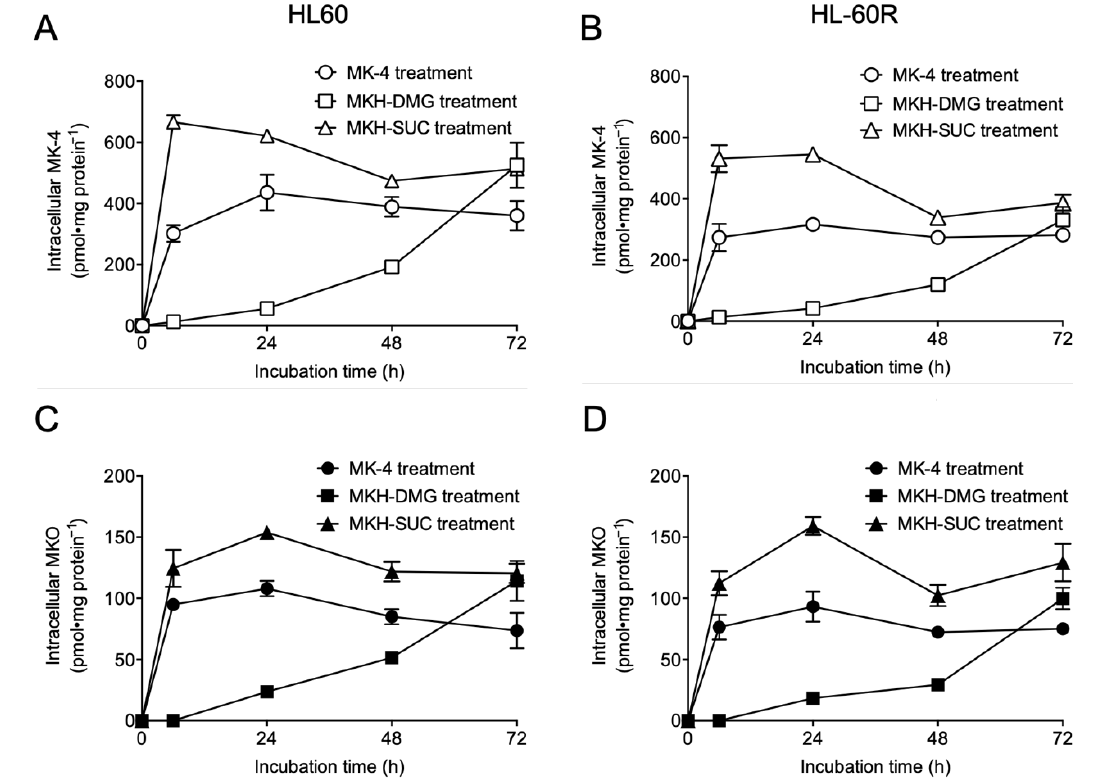
Figure 4. Intracellular concentration of MK-4 and MKO in HL60 and HL-60R cells treated with MK-4 or MKH derivatives. Intracellular MK-4 levels in HL60 ( A ) and HL-60R ( B ) cells treated with 5 μM MK-4, MKH-DMG, or MKH-SUC up to 72 h, and intracellular MKO levels in HL60 ( C ) and HL-60R ( D ) cells treated with 5 μM MK-4, MKH-DMG, or MKH-SUC up to 72 h. Plotted values are mean ± SD (n = 3). Table 2. Area under the curve over 72 h (AUC 0–72h ) of intracellular concentrations of MK-4 and MKO in HL60 and HL-60R cells treated with 5 μM MK-4, MKH-DMG, or MKH-SUC. Compound